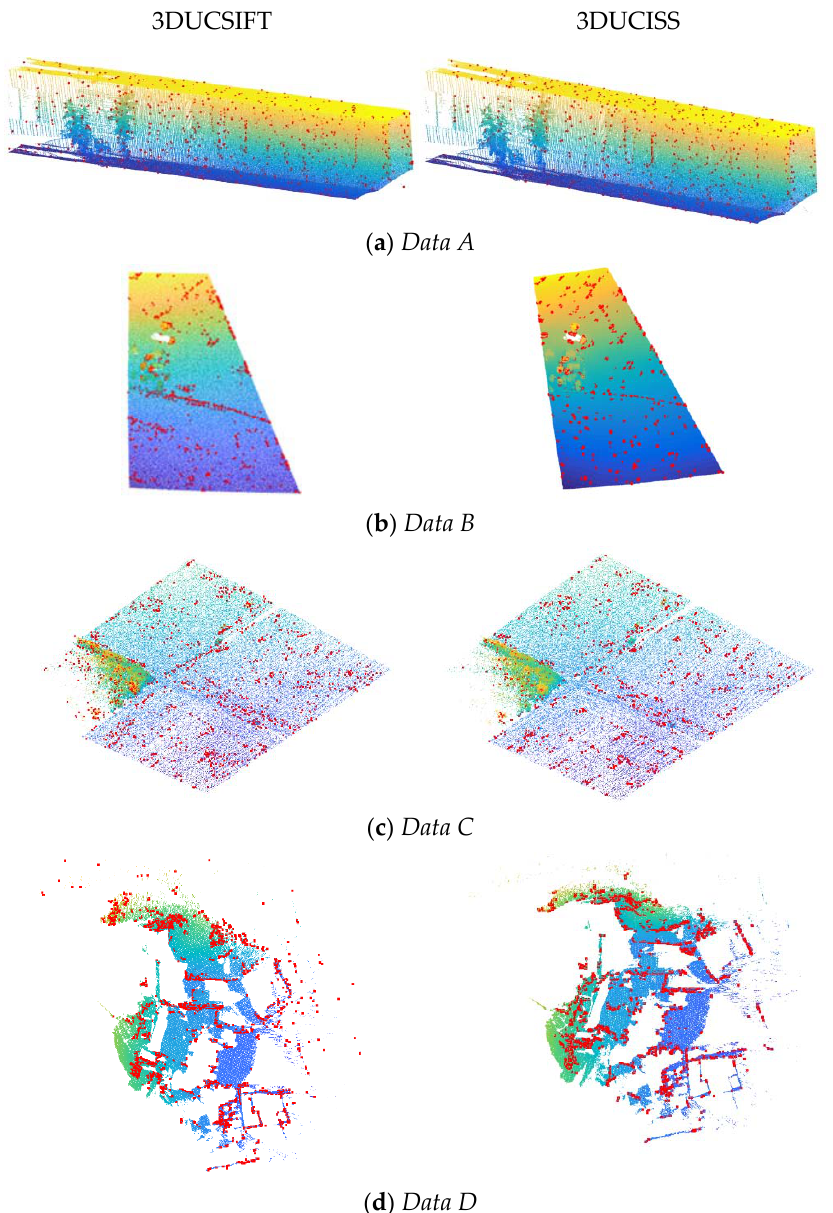
Figure 9. The result of 3D keypoints detection by the proposed method. The left column is the 3D keypoints detection result of the proposed method using 3DSIFT(3DUCSIFT) and the right column is the 3D keypoints detection results of the proposed method using 3DISS (3DUCISS).